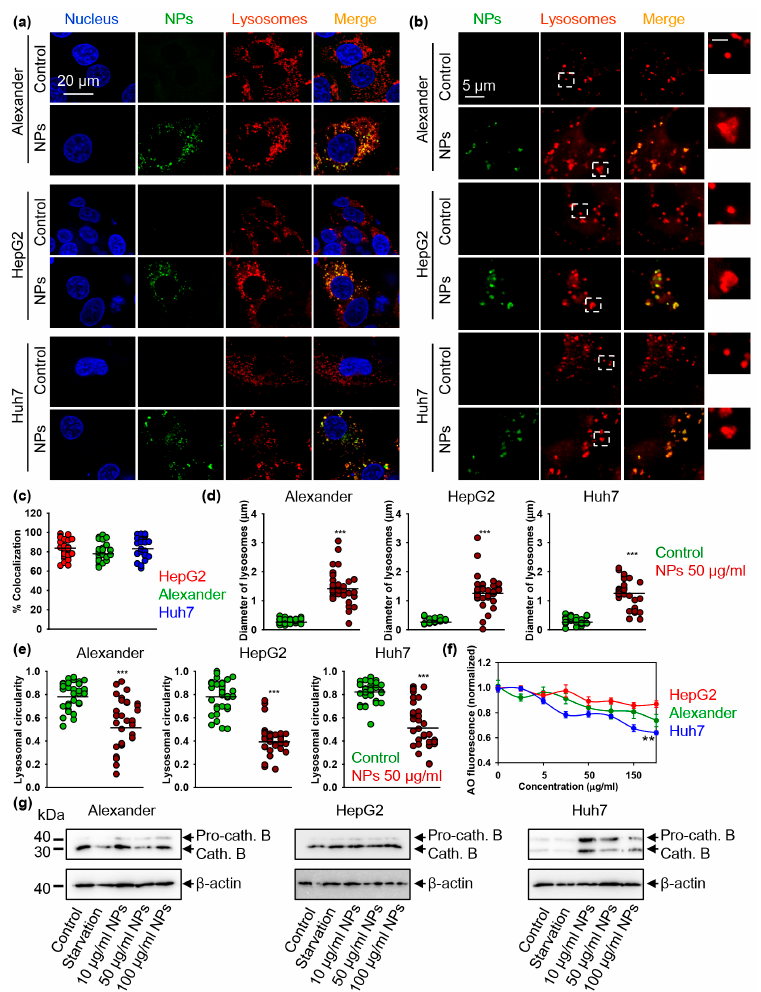
Figure 5. Lysosomal impairment induced by nanoparticles. ( a ) Localization of fluorescently labeled nanoparticles (green) in lysosomal compartments. Cells were treated for 12 h with nanoparticles 50 μ g Fe mL − 1 and labeled with LysoTracker™ Red DND-99 (red). Nuclei were stained with hoechst 33342 nuclear stain (blue). Merge of green and red gives yellow color. Labeled cells were then imaged using spinning disk confocal microscopy. ( b ) IXplore SpinSR Olympus super-resolution microscopy of lysosomes. Cells were treated for 12 h with nanoparticles 50 μ g Fe mL − 1 (green) and labeled with LysoTracker™ Red DND-99 (red). Scale bar for the zoomed insert is 1 μ m. ( c ) Colocalization analysis of nanoparticles and lysosomes from images ( a ) is presented. Quantifications performed using ImageJ are presented as means of n = 25 cells. ( d ) Measurements of the lysosomal diameter upon nanoparticle uptake. Super-resolution images ( b ) were quantified using ImageJ software. Quantifications are presented as means of n = 34 cells. (***) p < 0.001 denotes significant differences with respect to control (no particles treatment). ( e ) Assessment of lysosomal circularity out of super-resolution images ( b ). Circularity was calculated using ImageJ software. Quantifications are presented as means of n = 34 cells. (***) p < 0.001 denotes significant differences with respect to control (no particles treatment). ( f ) Lysosomal integrity as measured by acridine orange (AO) red fluorescence decrease. Cells were treated with indicated concentrations of nanoparticles for 24 h, stained with AO and then the fluorescence intensity was measured using a fluorescent microplate reader. The data are expressed as mean ± SEM, n = 3 each. (**) p < 0.01 denotes significant di ff erences. ( g ) Nanoparticles impair maturation of pro-cathepsin B in Alexander and Huh7 cells but not in HepG2. Cells were stimulated with nanoparticles at indicated concentrations for 12 h. Expression of cathepsin B was analyzed by immunoblotting. Positive control—serum starvation for 12 h. Actin denotes loading control. Densitometric quantification of blots is shown in Figure S7 of Supplemental